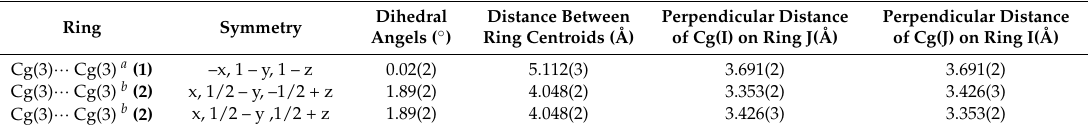
Table 3. Aromatic-aromatic interactions of 1 and 2 .